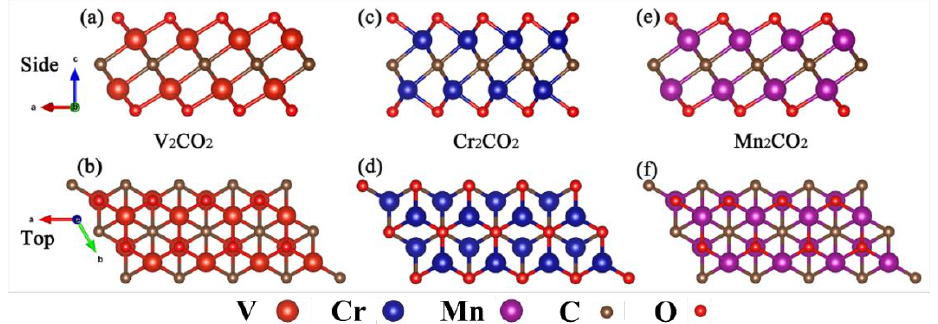
Figure 1. V 2 CO 2 , Cr 2 CO 2 , and Mn 2 CO 2 structures: ( a , c , e ) and ( b , d , f ) are the side and top views of V 2 CO 2 , Cr 2 CO 2 , and Mn 2 CO 2 structures, respectively.